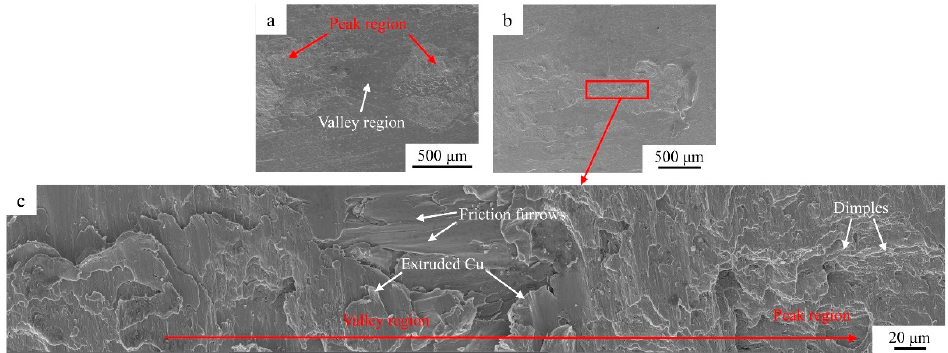
Figure 13. SEM images of the fracture surfaces of joints without ( a ) and with ( b , c ) alcohol at 0.45 MPa welding